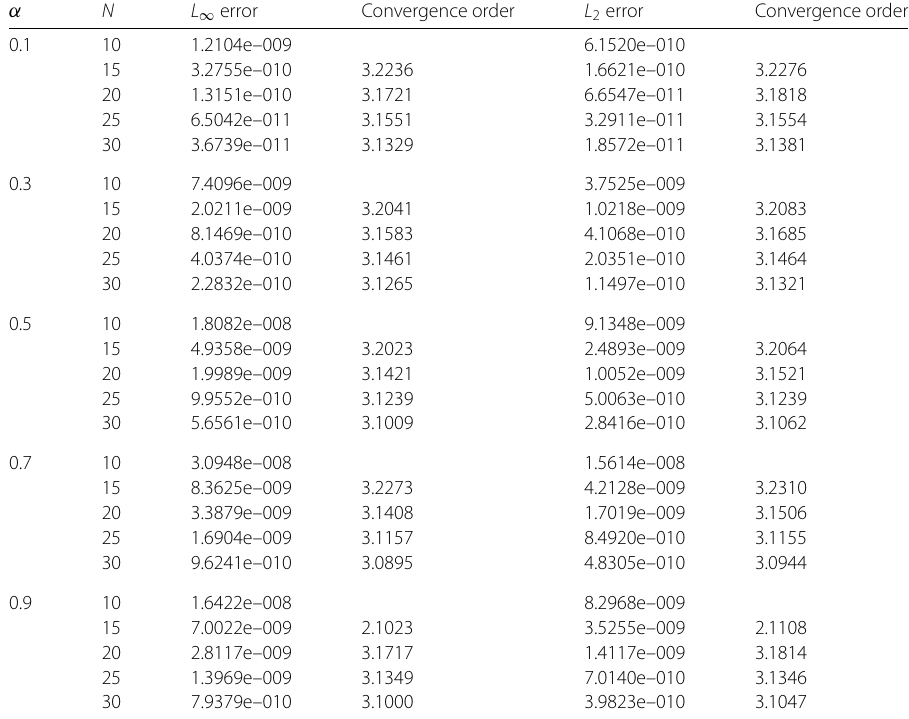
Table 5 The L ∞ , L 2 errors and temporal convergence orders for Example 3